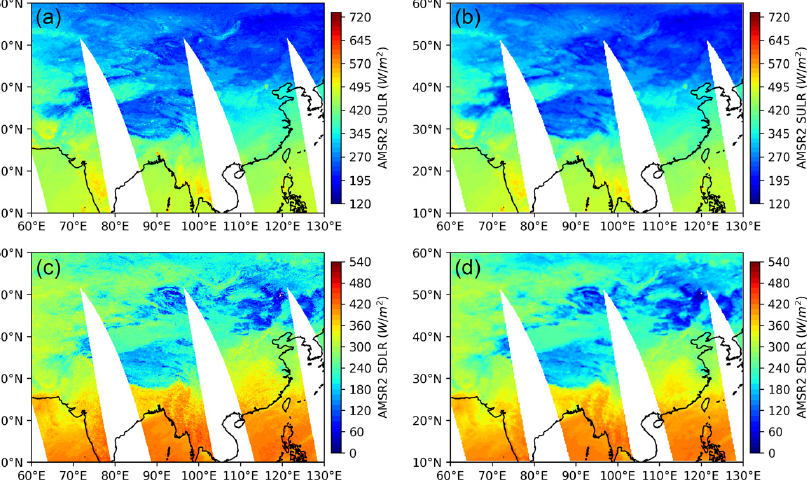
Figure 10. Comparison between the 10- and 25-km surface longwave radiation of the Advanced Microwave Scanning Radiometer 2 (AMSR2) ascending data in Asia on 1 January 2020. ( a ) AMSR2 10-km surface upward longwave radiation (SULR); ( b ) AMSR2 25-km SULR; ( c ) AMSR2 10-km surface downward longwave radiation (SDLR); and ( d ) AMSR2 25-km SDLR.